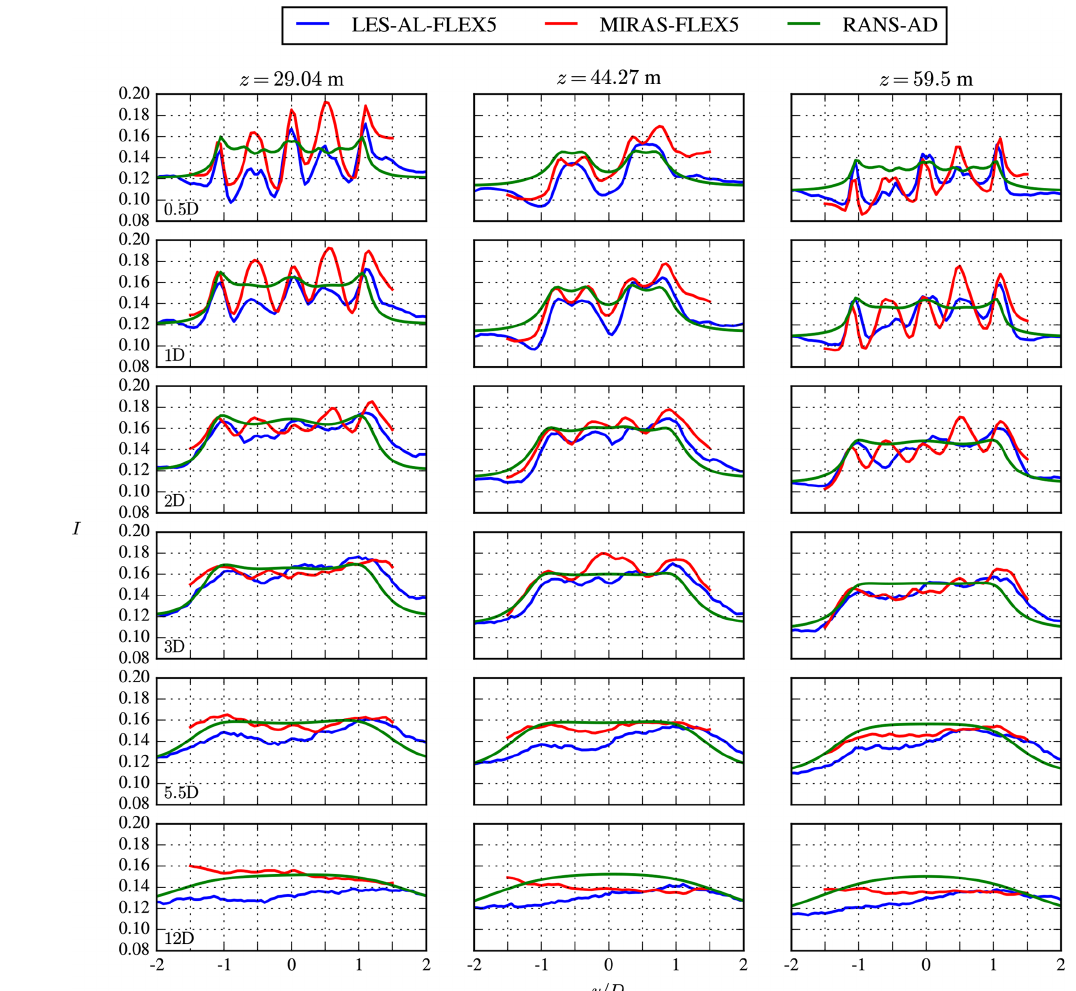
Figure 17. Far-wake case: profiles of turbulence intensity at three heights and six downstream distances.